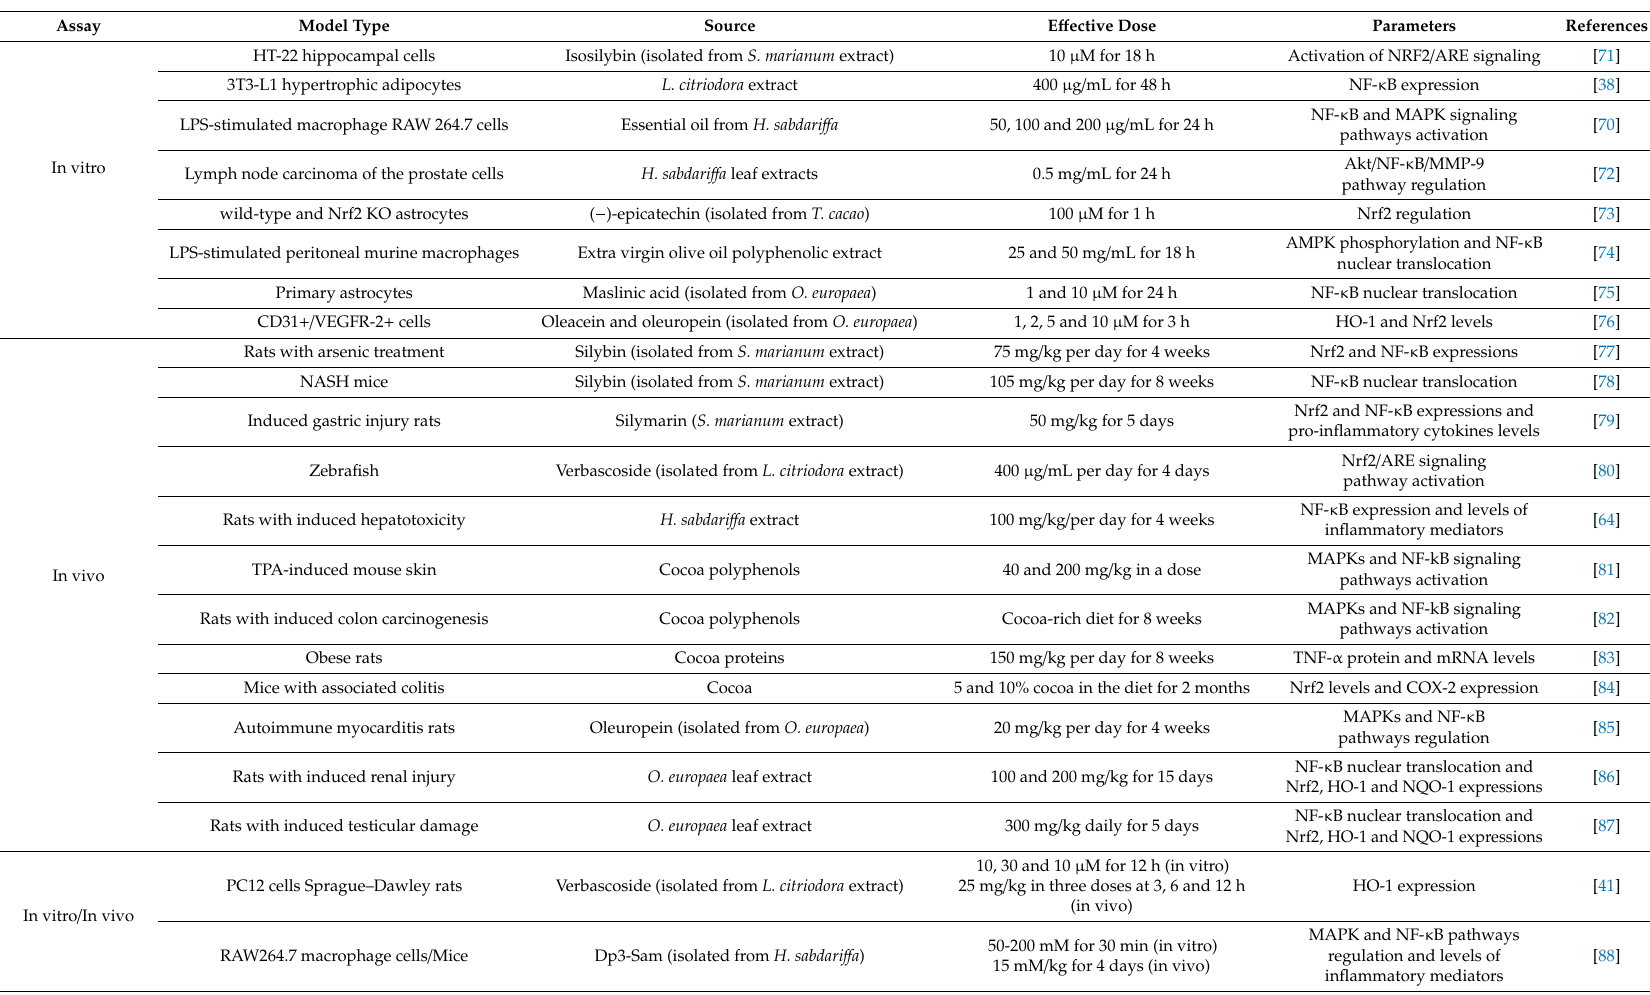
Table 2. Main parameters of the tests that show the e ff ects of di ff erent plant species on the main metabolic pathways related to inflammation.